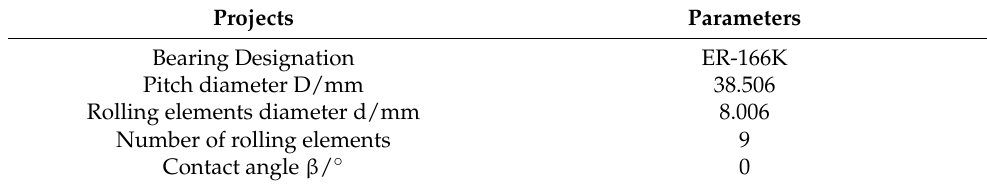
(b) Figure 24. Result of the test bearing.( a ) Time-domain waveform of the vibration signal; ( b ) enve- lope spectrum of the vibration signal. First, the adaptive quadrature matching pursuit algorithm is used to separate the harmonic and modulation components, and an over-complete Fourier dictionary of 10,000 × 20,000 is established. The sparsity of the dictionary is 6, which appears in numbers 39,